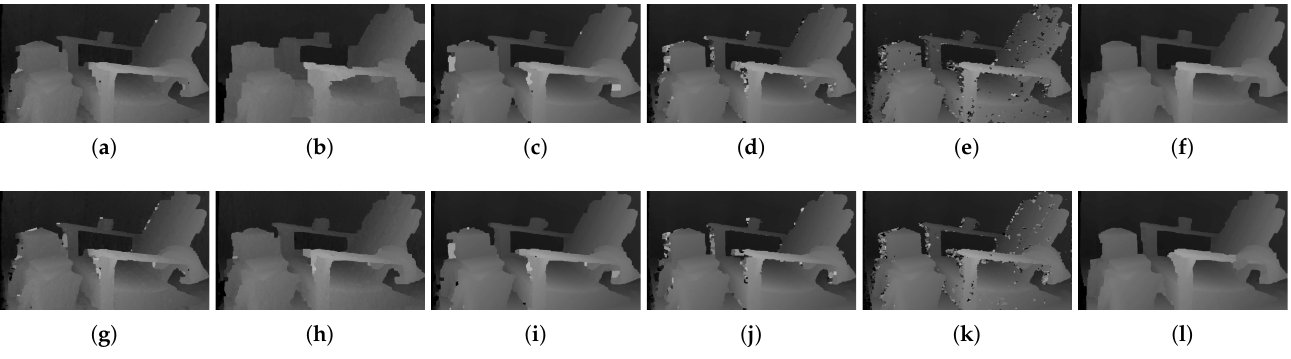
Figure 26. Estimated disparity images of the combinations of cost and image filter using the GC stereo method, according to low and high gain parameters. The images in the top row show disparities at the low gain parameter, and the images in the bottom row show those at the high gain parameter, respectively. ( a ) GC, AD. ( b ) GC, Mean/AD. ( c ) GC, LoG/AD. ( d ) GC, BilSub/AD. ( e ) GC, Rank/AD. ( e ) GC, Census. ( g ) GC, AD. ( h ) GC, Mean/AD. ( i ) GC, LoG/AD. ( j ) GC, BilSub/AD. ( k ) GC, Rank/AD. ( l ) GC, Census.